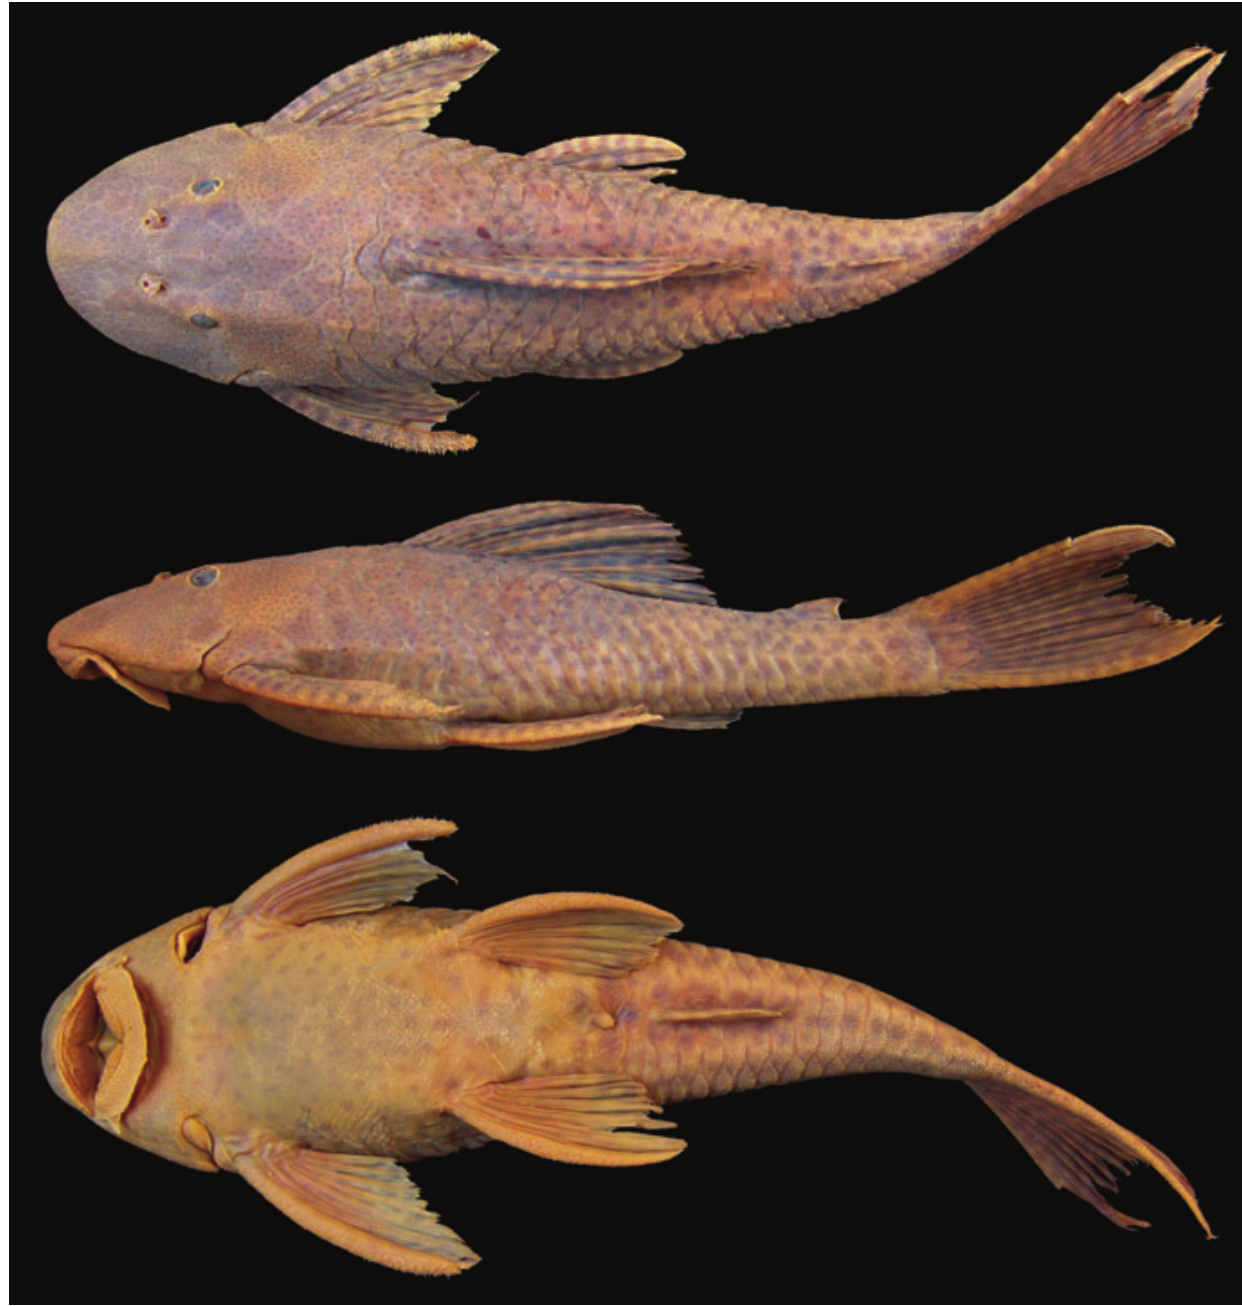
Fig. 7. Holotype of Hypostomus nigropunctatus n. sp., MZUSP 106072, 184.4 mm SL, rio Iguaçu, Municipality of